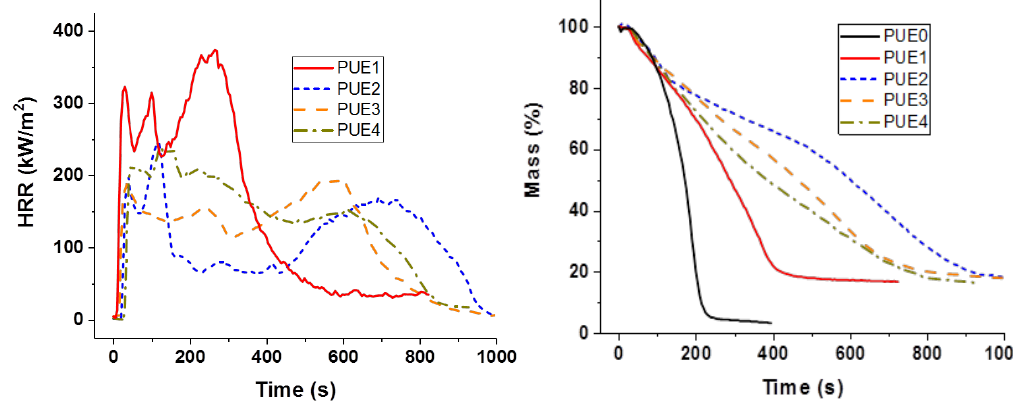
Figure 10. Heat release rate and mass for PUE/APP/S9 composites from cone calorimeter.